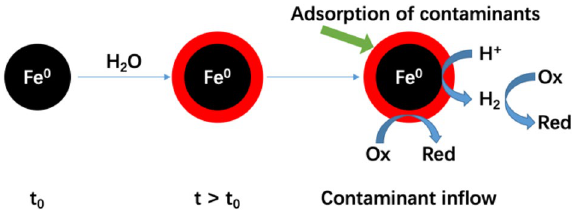
Figure 1. Principle of contaminant removal process in Fe 0 /H 2 O